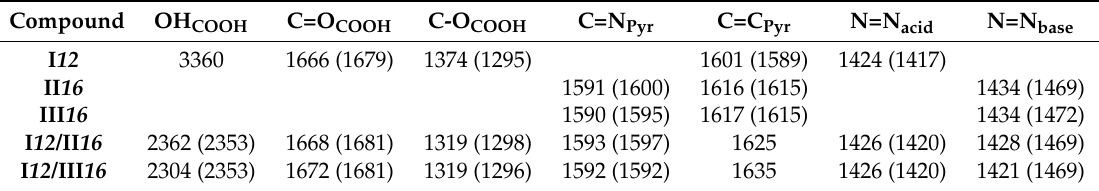
Table 4. The wave numbers theoretically (experimentally) of characteristic groups of I 12 , II 16 , III 16, I 12 /II 16 and I 12 /III 16.